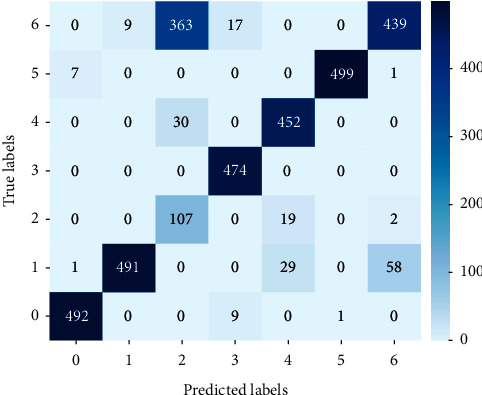
The classification results of samples with fd = -0.02.